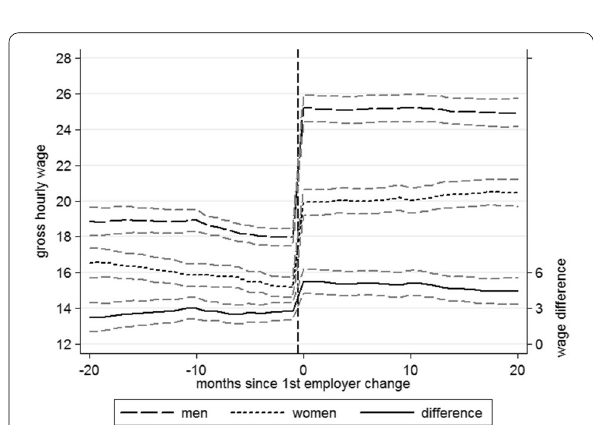
Fig. 6 Gender-specific changes in pay: hourly wages of employer changers and 95% CIs ( Source BAP 2005/06, author’s calculations; created with Stata13)